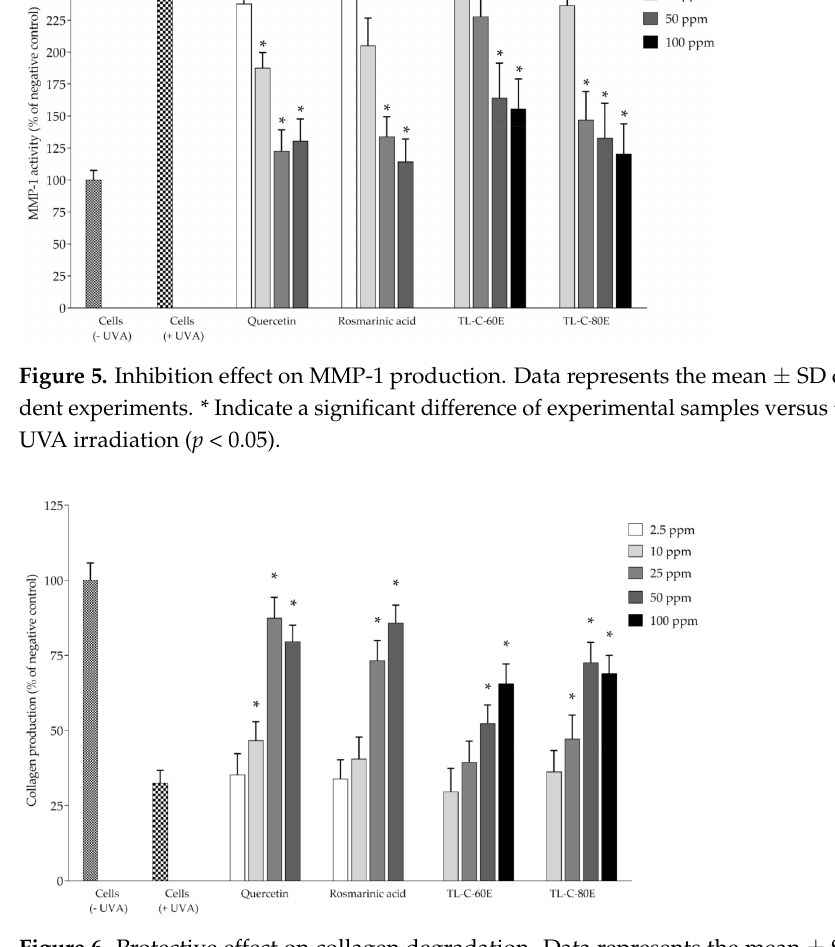
Figure 6. Protective effect on collagen degradation. Data represents the mean ± SD of three inde- pendent experiments. * Indicate a significant difference of experimental samples versus treated cells with UVA irradiation ( p <